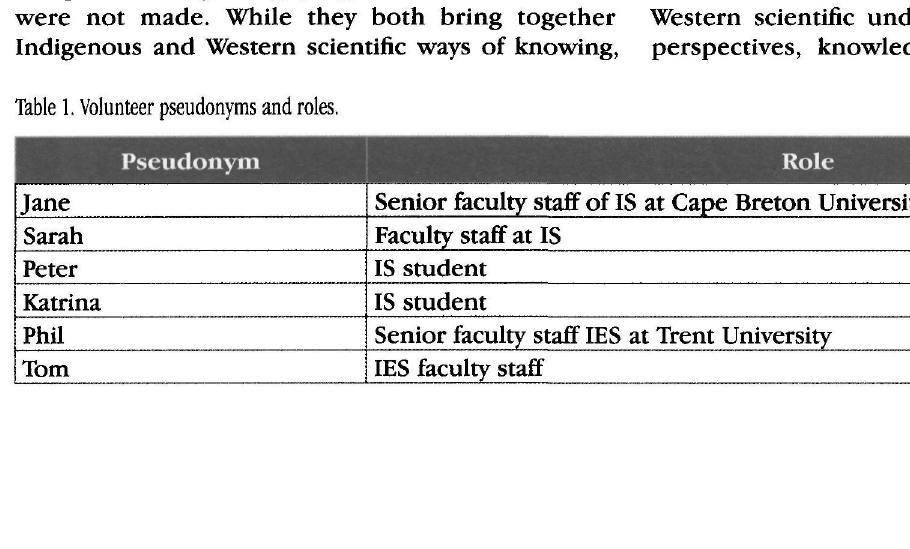
Table 1. Volunteer pseudonyms and